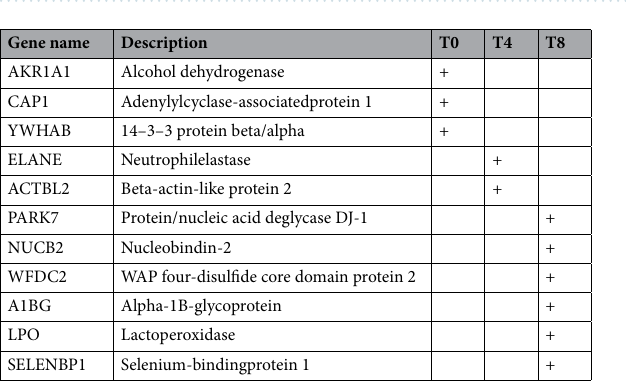
Figure 1. Tears proteins identification and statistic. ( A ) Venn diagram of quantified proteins in tears of NK patients at baseline (T0), after 4 (T4) and 8 weeks (T8) of treatment with rhNGF . Volcano Plot of proteins graphed by fold change (Difference) and − Log(P value) by the comparison of T4 vs T0 ( B ); T8 vs T0 ( C ); T4 vs T8 ( D ). Blue dots represent proteins that were not differentially expressed in the comparison carried out; red dots represent proteins that are significantly up-regulated (right dots in the Volcano plot) or down-regulated (left dots in the plot) in each investigated comparison.